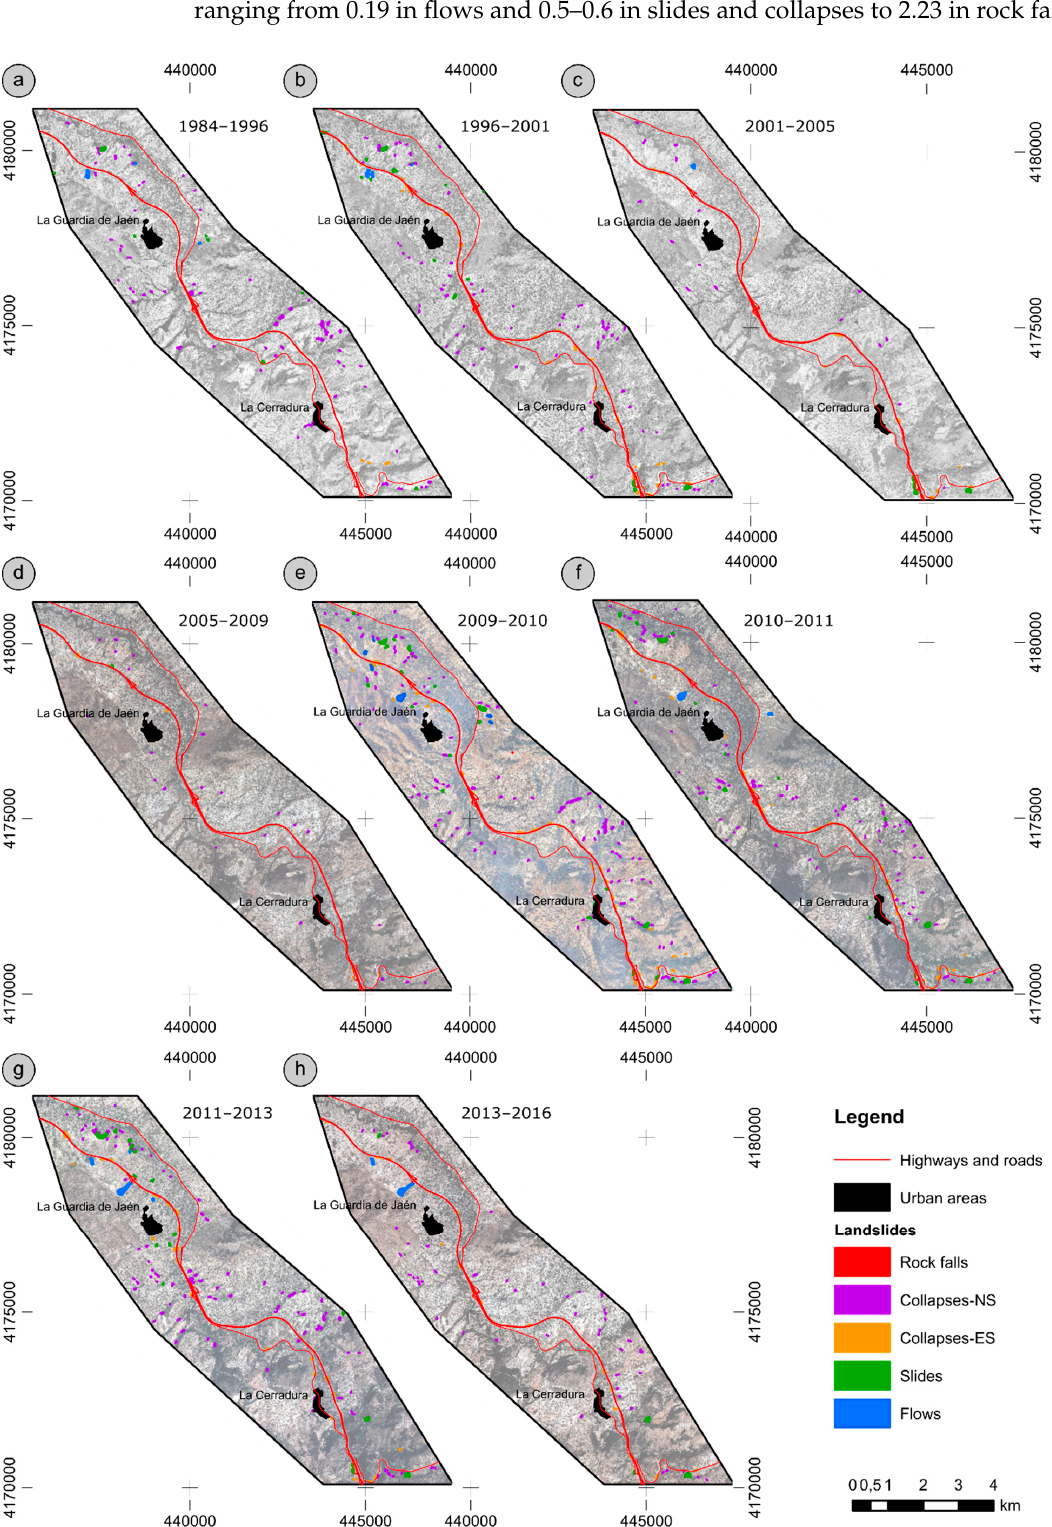
Figure 5. Multitemporal landslide inventory: ( a ) 1984–1996; ( b ) 1996–2001; ( c ) 2001–2005; ( d ) 2005–2009; ( e ) 2009–2010; ( f ) 2010–2011; ( g ) 2011–2013; ( h ) 2013–2016. Collapses in natural slopes (NS) and in engineering slopes (ES). Coordinates are found in ETRS89 ‐ UTM30.